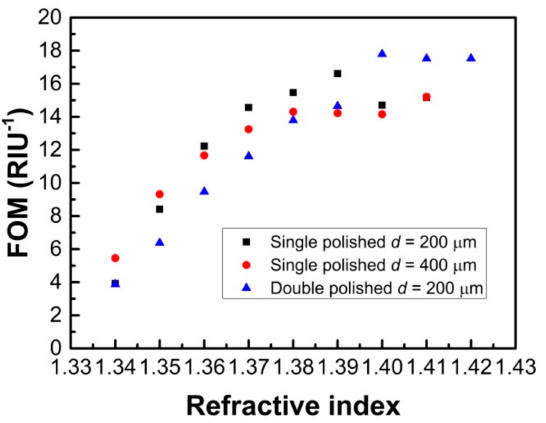
Figure 12. The figure of merit (FOM) for the single and double-sided polished sensor